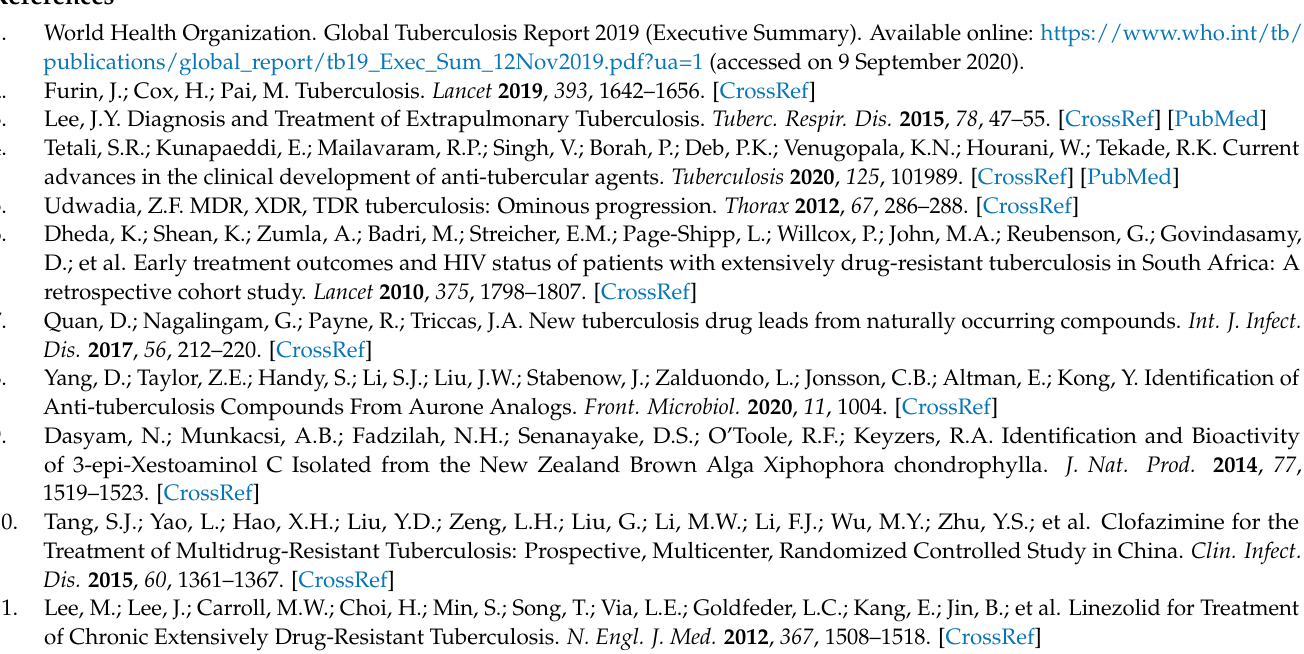
dure, characterization details of 2-(5-bromo-2-fluorophenyl)-2,3-dihydroquinazolin-4(1 H )-one ( 3l ); Figure S1: FT-IR of 2-(5-bromo-2-fluorophenyl)-2,3-dihydroquinazolin-4( 1H )-one ( 3l ); Figure S2: 1 H- NMR of 2-(5-bromo-2-fluorophenyl)-2,3-dihydroquinazolin-4(1 H )-one ( 3l ); Figure S3: 13 C-NMR of 2-(5-bromo-2-fluorophenyl)-2,3-dihydroquinazolin-4(1 H )-one ( 3l ); Table S1: Reported essen- tial and potential mycobacterial drug targets. Table S2: The selected 20 essential mycobacterial drug targets that we used for molecular modeling studies. References [86–119] are cited in the Supplementary